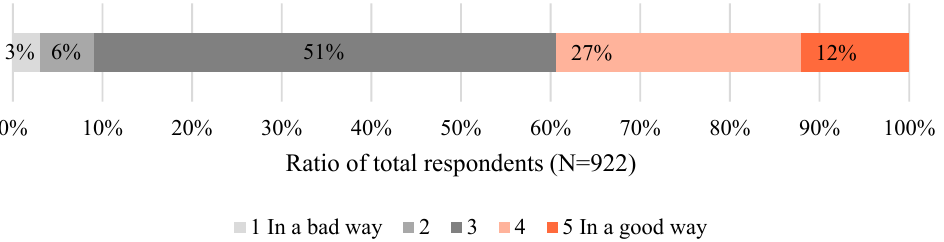
Figure 12. Possibility of influence on work activities of smart grids.